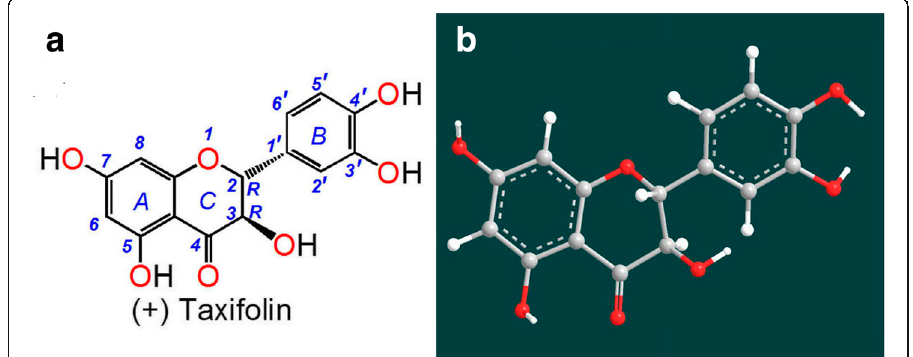
Fig. 1 Structure ( a ) and preferential conformation-based ball-and-stick model ( b ) of (+)